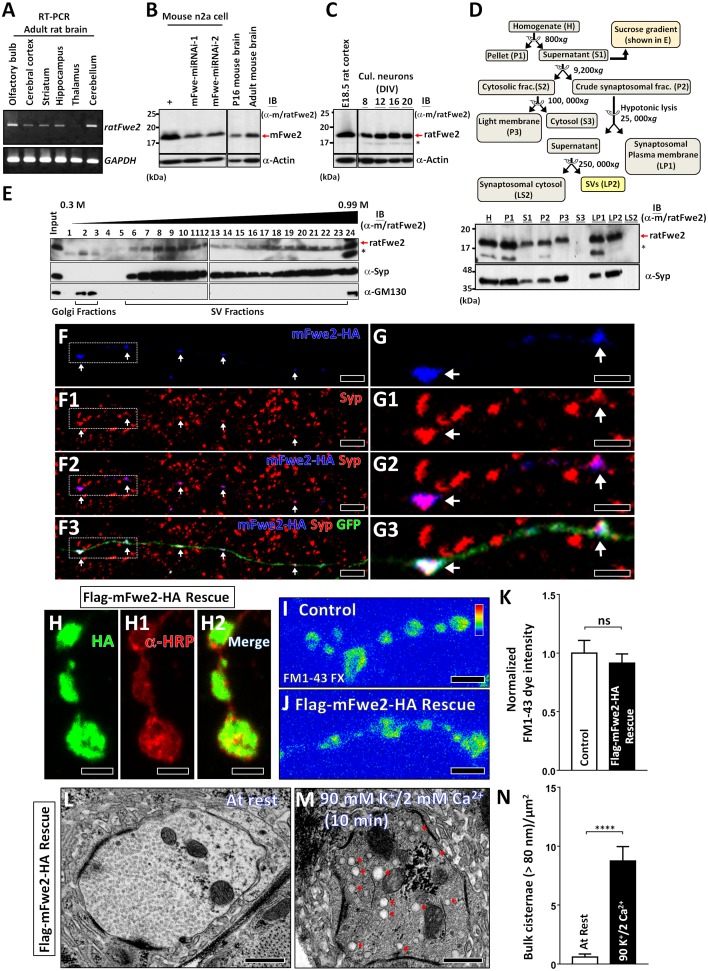
Rodent Fwe isoform 2 is localized on the Synaptic Vesicles (SVs) and triggers Clathrin-Mediated Endocytosis (CME) and Activity-Dependent Bulk Endocytosis (ADBE) at the Drosophila Neuromuscular Junction (NMJ).(A) In semiquantitative reverse-transcription PCR (RT-PCR) assays, the expression of ratFwe2 mRNA was detected in distinct regions of adult rat brain. The PCR products of ratFwe2 cDNA were sequenced to validate the identity of ratFwe2 mRNA. The expression of GAPDH mRNA was used as the internal control. (B) In immunoblots with α-m/ratFwe2, mFwe2 was detected in the lysates of mouse neuroblastoma Neuro 2a (n2a) cells. This blotting signal is further reduced by expressing either one of two different mFwe-microRNAi (miRNAi). This isoform is also present in postnatal day 16 and adult mouse brains. Actin was used as the loading control. (C) In the immunoblots with α-m/ratFwe2, ratFwe2 was detected in the embryonic rat brain as well as in different days in vitro (DIV) cultured rat hippocampal neurons. Actin was used as the loading control. (D) The subcellular fractions were obtained from adult rat brain extracts using a series of centrifugations. ratFwe2 was found in the synaptosomal plasma membrane (lysate pellet 1 [LP1]) and SV fractions (lysate pellet 2 [LP2]) but was not detected in the cytosolic fraction (lysate supernatant 2 [LS2]). * indicates a degraded product of ratFwe2 or nonspecific antibody binding. (E) The subcellular fractions of adult rat brain were separated by 0.3–0.99 M sucrose gradients. ratFwe2 is present in the SV fractions containing Synaptophysin (Syp). Immunoblotting for GM130, a Golgi protein, labels Golgi fractions. (F–G) Confocal Z-projection images of DIV14 cultured rat hippocampal neurons stained with α-HA (blue), α-Syp (red), and α-GFP (green) were captured from neurons transfected with pSpCas9(BB)-m/ratFwe-gRNA-2A-GFP-2A-mFwe2-HA plasmid. White arrows indicate the presynaptic terminals. The enlarged images for white dashed boxes in F are shown in G. Axons are outlined by α-GFP staining. mFwe2-HA proteins are largely colocalized with Syp in the presynaptic terminals. (H–H2) Confocal Z-projection images of Drosophila NMJ boutons stained with α-HRP (red) and α-HA (green) were obtained from fwe mutants expressing Flag-mFwe2-HA (nSyb(w) > flag-mFwe2-HA in fweDB25/fweDB56). (I–J) Confocal Z-projection images of Drosophila NMJ boutons labeled with fixable FM1-43 dye were obtained from FRT80B control larvae (I) and Flag-mFwe2-HA-rescued larvae (J). CME was elicited by 1-min 90 mM K+/0.5 mM Ca2+ stimulation in the presence of 4 μM fixable FM1-43 dye. (K) Data quantifications for the FM1-43 dye intensity within the type Ib boutons shown in I–J. The FM1-43 dye fluorescence intensities were measured, and the values are normalized to the average value of controls. The neuronal expression of Flag-mFwe2-HA rescues the FM1-43 dye uptake defect in fwe mutants. Type Ib boutons of A2 muscles 6/7 were counted, and NMJs (control, n = 7; and Flag-mFwe2-HA rescue, n = 8) derived from 4 larvae were analyzed. (L–N) Transmission electron microscopy (TEM) images of NMJ boutons were captured from Flag-mFwe2-HA-rescued larvae. Samples were fixed under resting condition (10-min incubation in 5 mM K+/0 mM Ca2+ solution, L) or after 10-min 90 mM K+/2 mM Ca2+ stimulation (M). Data quantifications of the number of bulk cisternae per bouton area are shown in N. Type Ib boutons (at rest, n = 10; and 10-min 90 mM K+/2 mM Ca2+, n = 20) from 3 larvae for each condition were analyzed. A Student’s t test was used for statistical analysis. p-Value: ns, not significant; ****, p < 0.001. Error bars indicate the standard error of the mean. Scale bar: 2 μm (G–G3); 5 μm (F–F3, H–H2); 10 μm (I–J); 500 nm (L–M). The underlying data can be found in S1 Data.